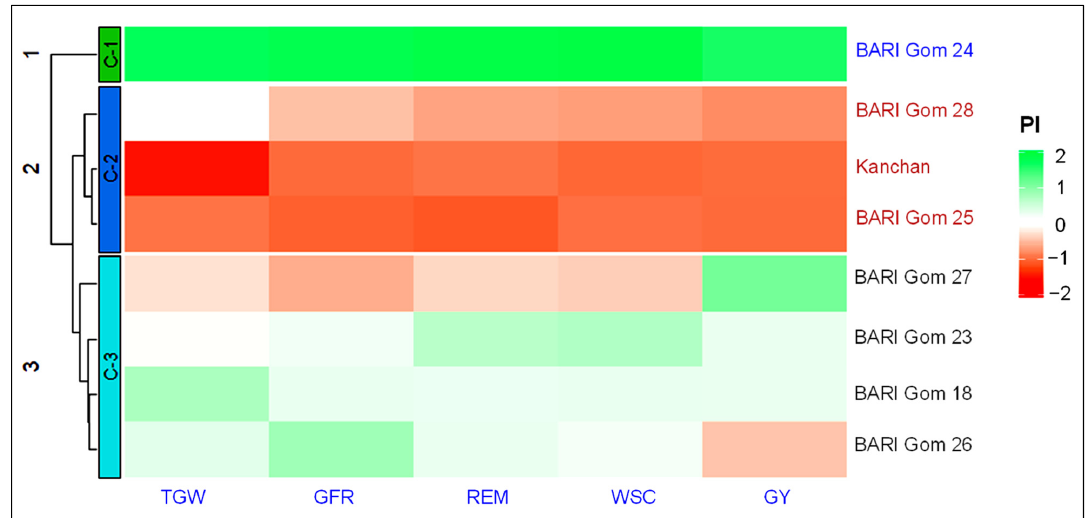
Figure 6. Hierarchical clustering heatmap based on the performances of eight wheat cultivars in important five traits under drought stress. The mean values of studied traits under drought conditions in all cultivars were normalized as a performance index (PI) and clustered. Three distinct clusters were obtained—tolerant (C-1), moderately tolerant (C-3), and sensitive (C-2) wheat cultivars based on the PI values. Different color scale expresses the intensity of the PI values of five important traits viz., GY, TGW, WSC, REM and GFR.